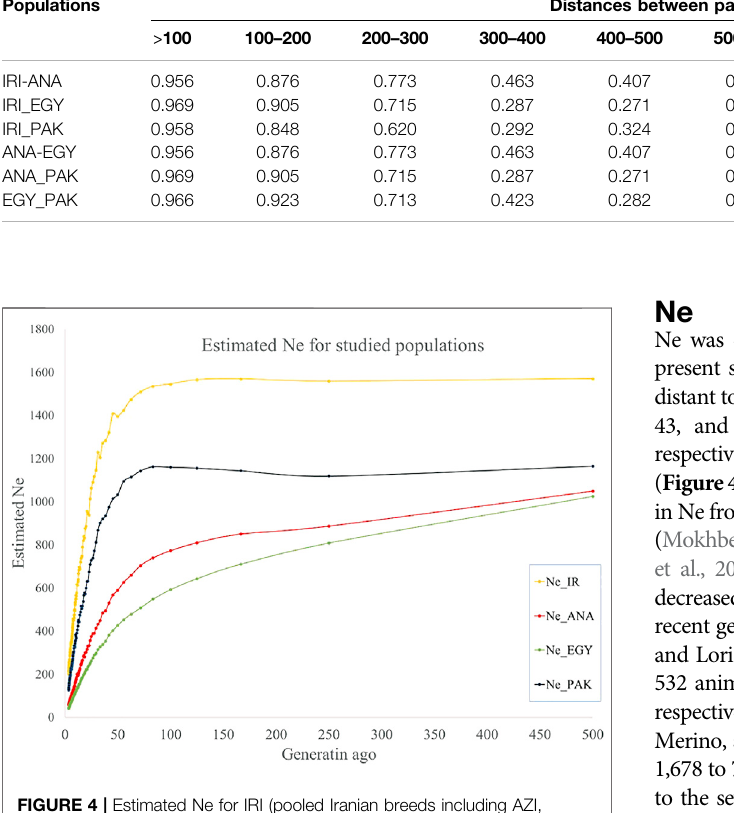
TABLE 3 | Consistency of gametic phase at given distances between IRI, ANA, EGY, and PAK water buffalo populations. Populations Distances between paired SNPs (kbp) > 100